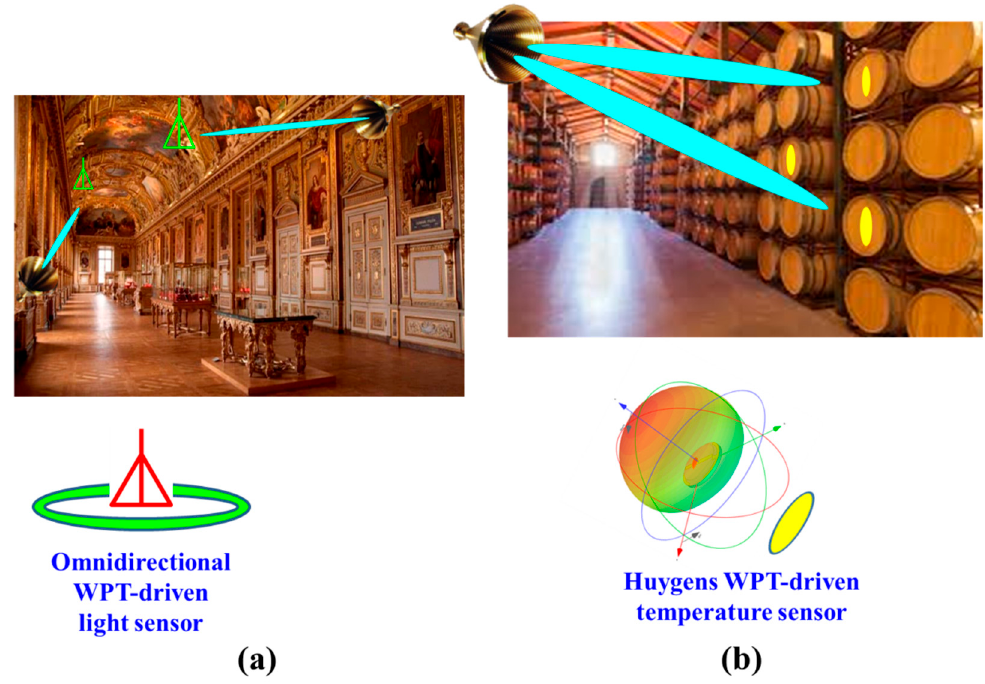
Figure 1. Illustrated applications of wirelessly powered Internet-of-things (IoT) sensors. ( a ) Ceiling light sensors in an art museum require omnidirectional wireless power transfer (WPT) capture capability. ( b ) Temperature sensors on wine barrels in a storage room require unidirectional broadside WPT capture capability.